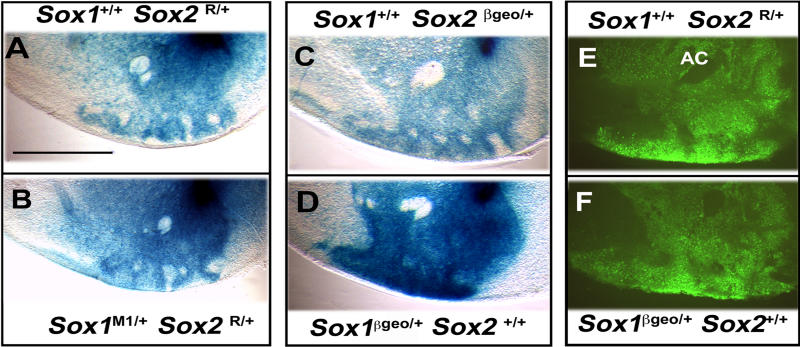
The Distribution of VS Neurons Is Unaffected in Mice Over-Expressing SOX1 from the Sox2
R Allele(A–D), X-gal staining of coronal sections from the ventral telencephalon of P0 mice. Note that there is no difference in the distribution of Sox2-expressing OT neurons with SOX1 (A) or without SOX1 (C), and in Sox2
R/+ mice with two wild-type Sox1 alleles (A) or one (B). Comparison of the number and distribution of neurons expressing Sox2
βgeo in (C) and Sox1
βgeo in (D) shows overlapping expression. (A–C) show 150-μm sections, and (D) shows a 80-μm section.(E and F) DARPP-32 immunostaining of coronal sections from the ventral telencephalon of P10 Sox2
R/+ and Sox1
βgeo/+ single heterozygous mice, showing no difference in the generation and migration of OT neurons. AC, anterior commissure. Scale bar = 100 μm.